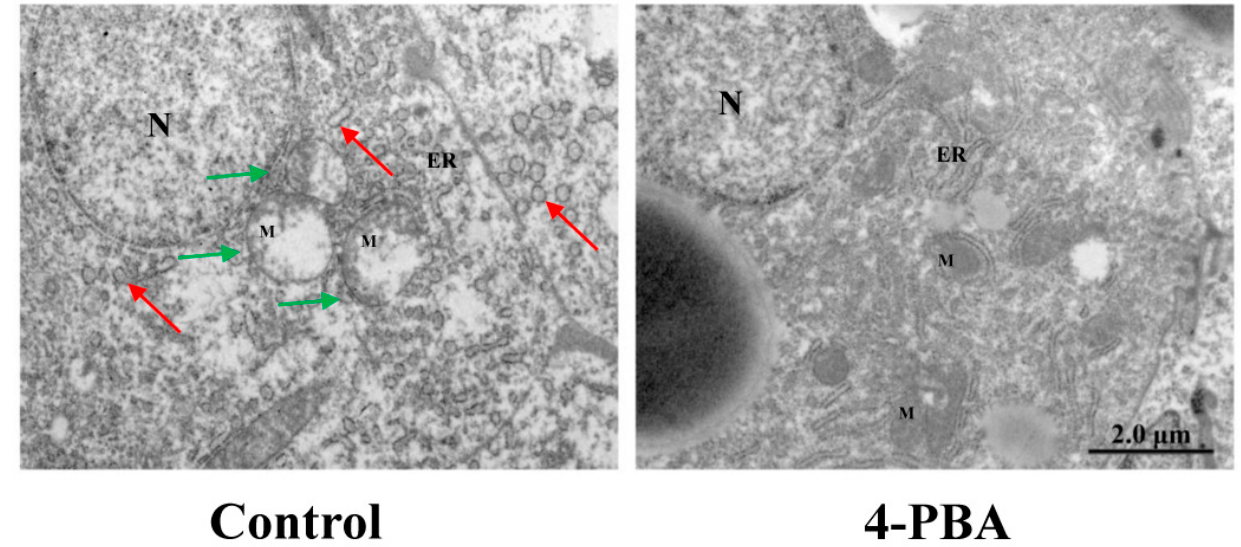
Figure 9. Hepatic transmission electron microscopy (TEM) images of L. maculatus after two weeks of being fed the test diets and 48 h of ammonia nitrogen exposure. (N—nucleus; M—mitochondrion; green arrows—damaged mitochondria; red arrows—damaged endoplasmic reticulum).